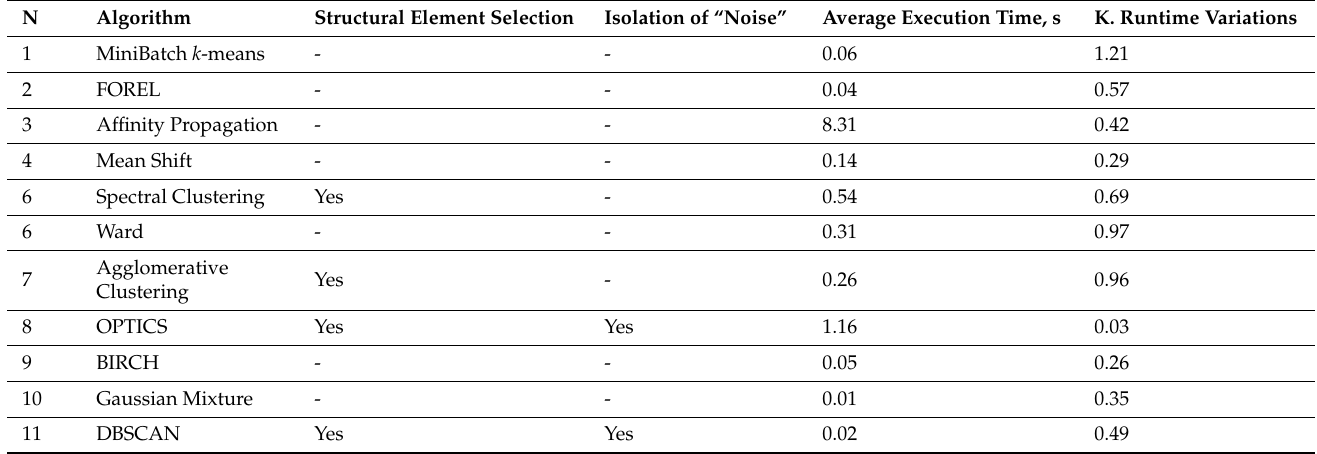
Table 1. Results of the study of clustering algorithms .